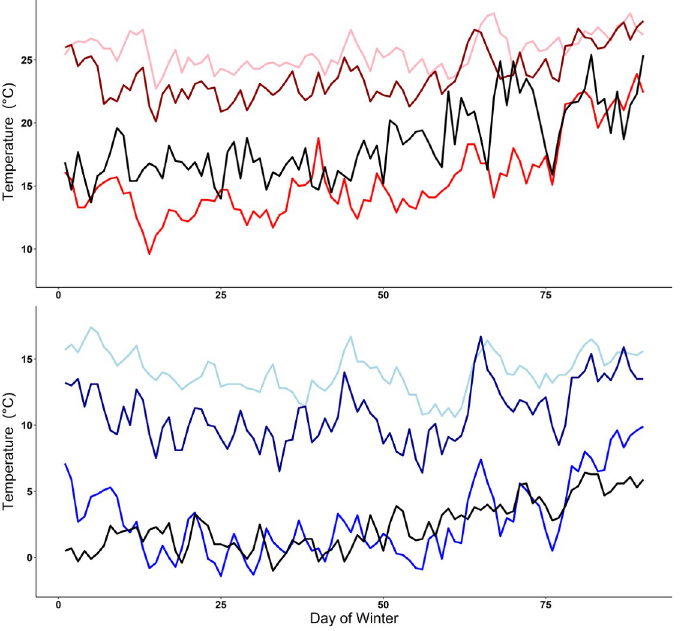
Fig 6. Comparison of ten-year mean air temperatures. Mean ten-year (2007–2016) daily high (top panel) and low (bottom panel) winter temperatures for Lee County, AL (study site; red line, top panel; blue line, bottom panel), Miami-Dade County, FL (invasive population; pink line, top panel; light blue line, bottom panel), Hillsborough County, FL (invasive population; dark red line, top panel; dark blue line, bottom panel), and near the southern limit of the native distribution in Santa Rosa, Argentina (black line, top and bottom panels). Includes winter period of 21 December– 20 March for the three North American sites and 21 June– 20 September for the South American location. Climate data retrieved from the National Oceanic and Atmospheric Administration (NOAA; https://www.ncdc.noaa. gov/cdo-web/datatools/selectlocation) in January 2020 from weather stations in Lee County, Alabama, USA